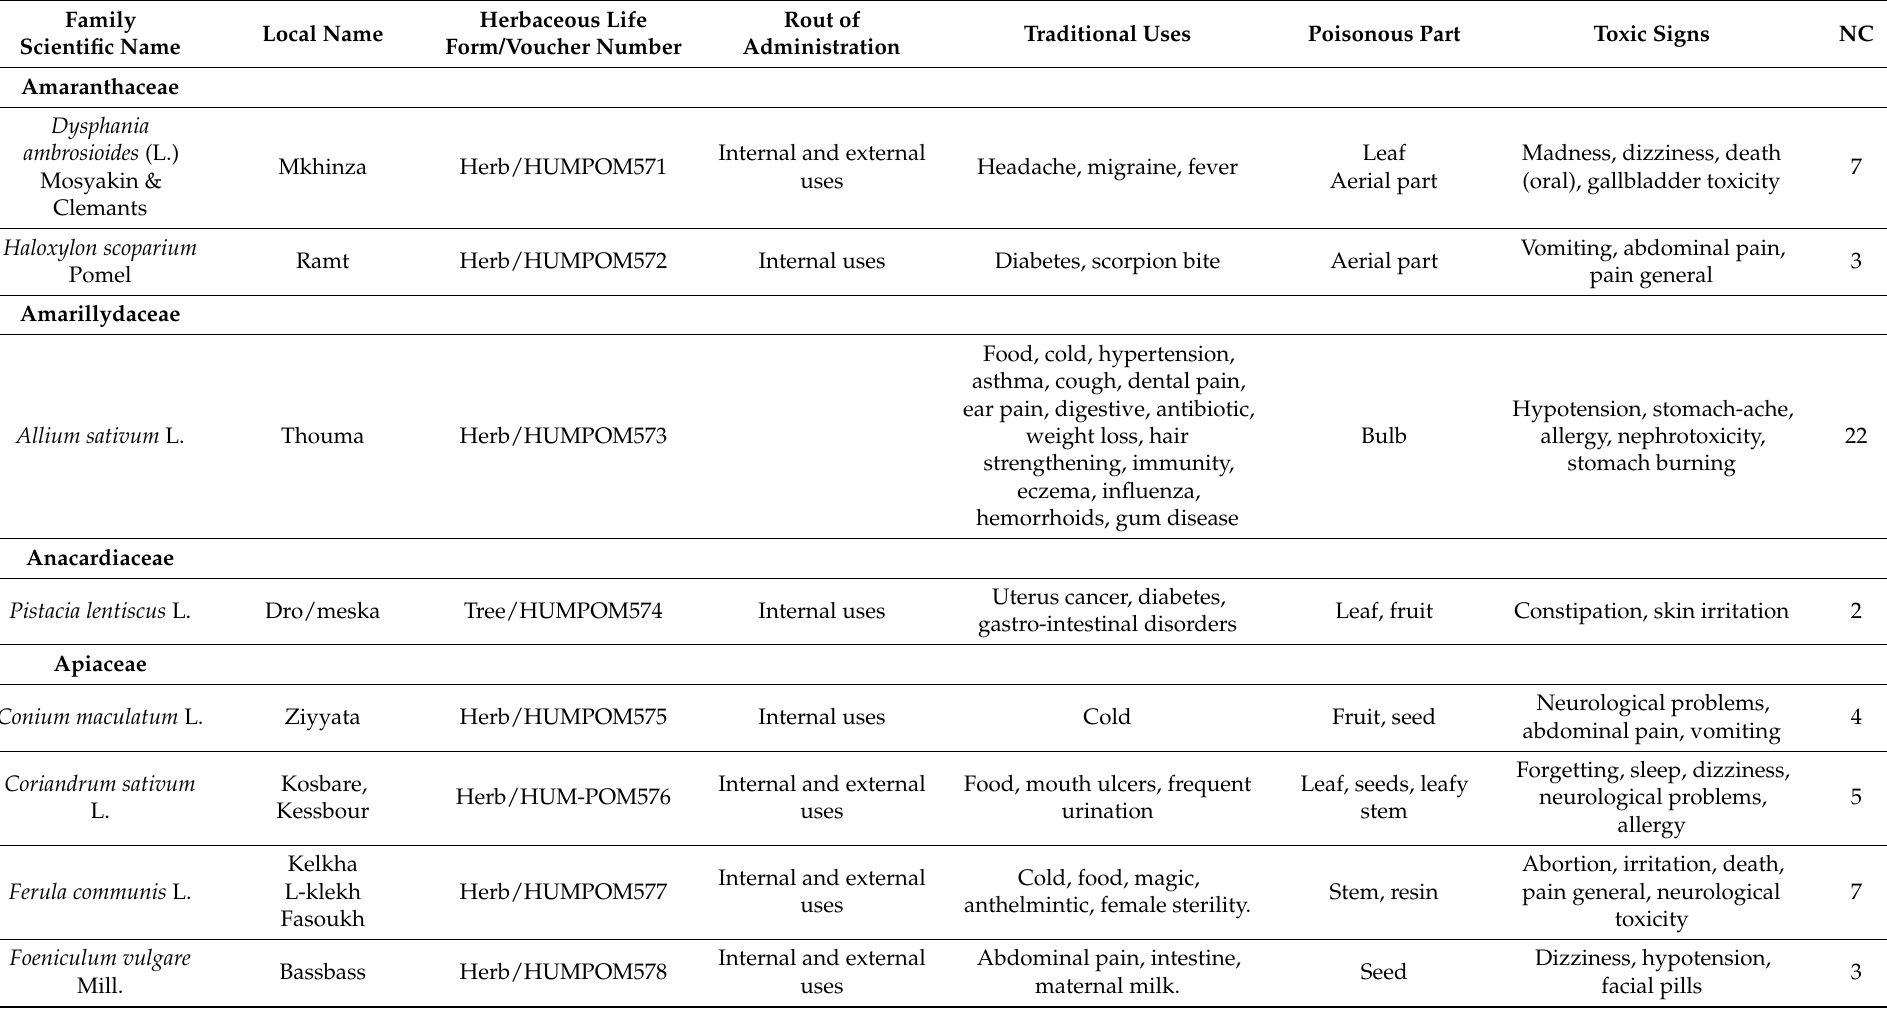
Table 2. List of toxic plants cited toxic by people in northeastern